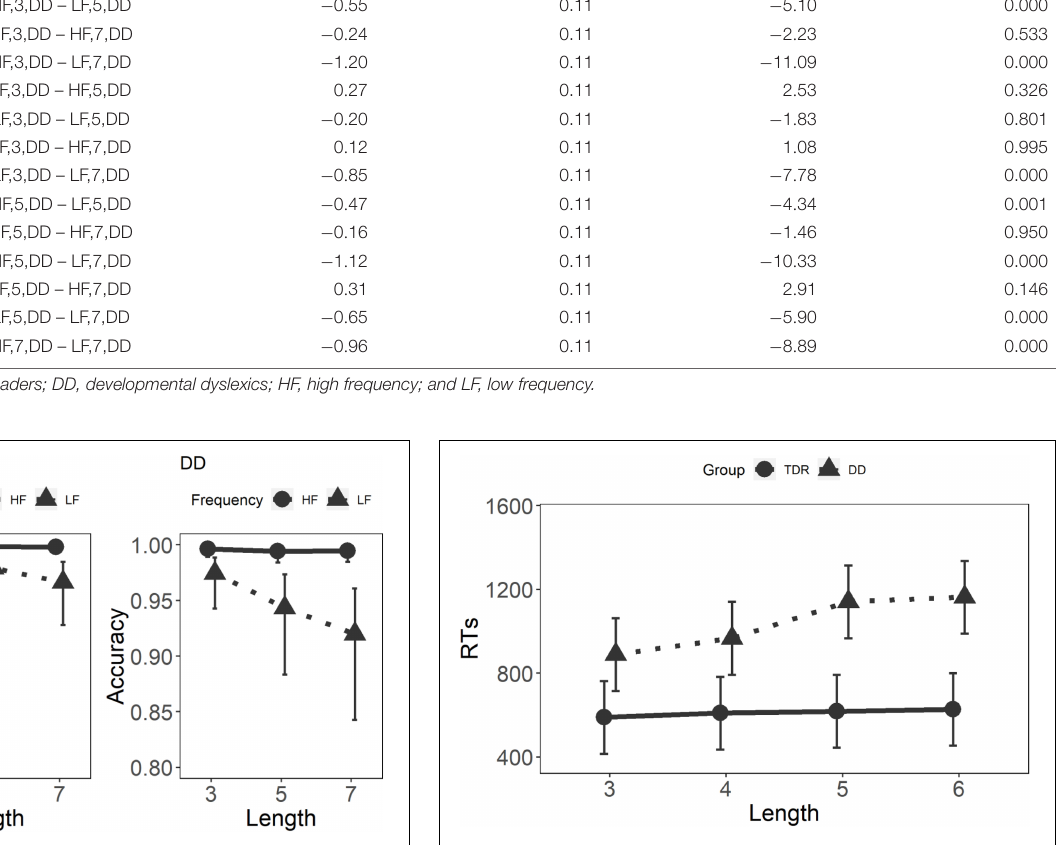
FIGURE 3 | Error rates in the two groups in each individual condition. TDR, typical developing readers; DD, developmental dyslexics; HF, high frequency; and LF, low frequency.